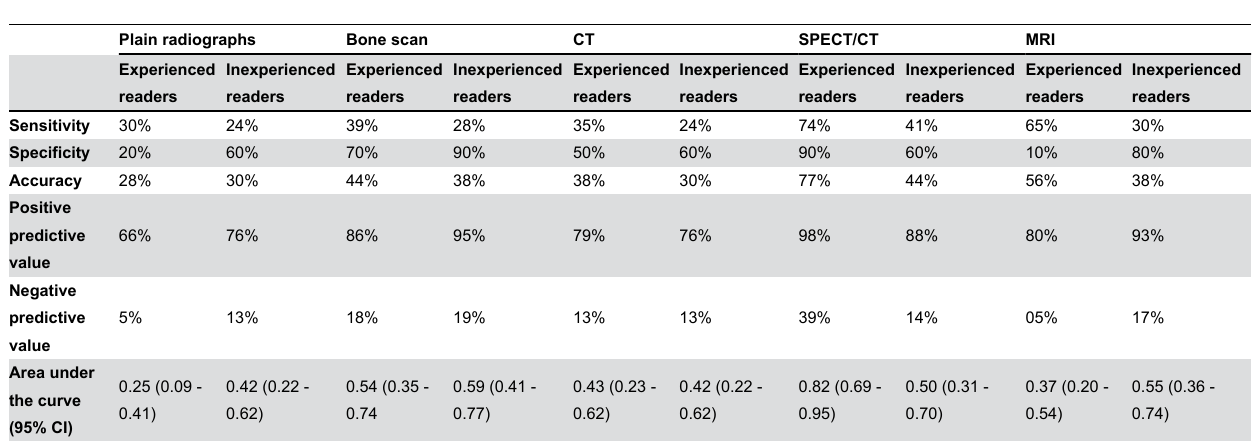
Table 2. Binary classification of lesion detection by all modalities for experienced and inexperienced readers.